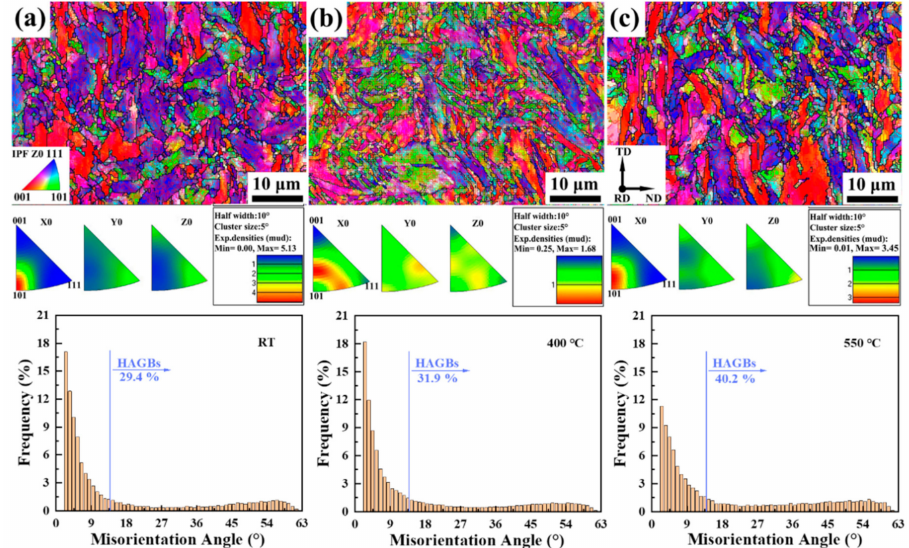
Figure 8. IPFs maps of plane C at ( a ) RT, ( b ) 400 ◦ C, and ( c ) 550 ◦ C of 9Cr-F/M steel and the histogram of misorientation angle of Z0 direction corresponding to each